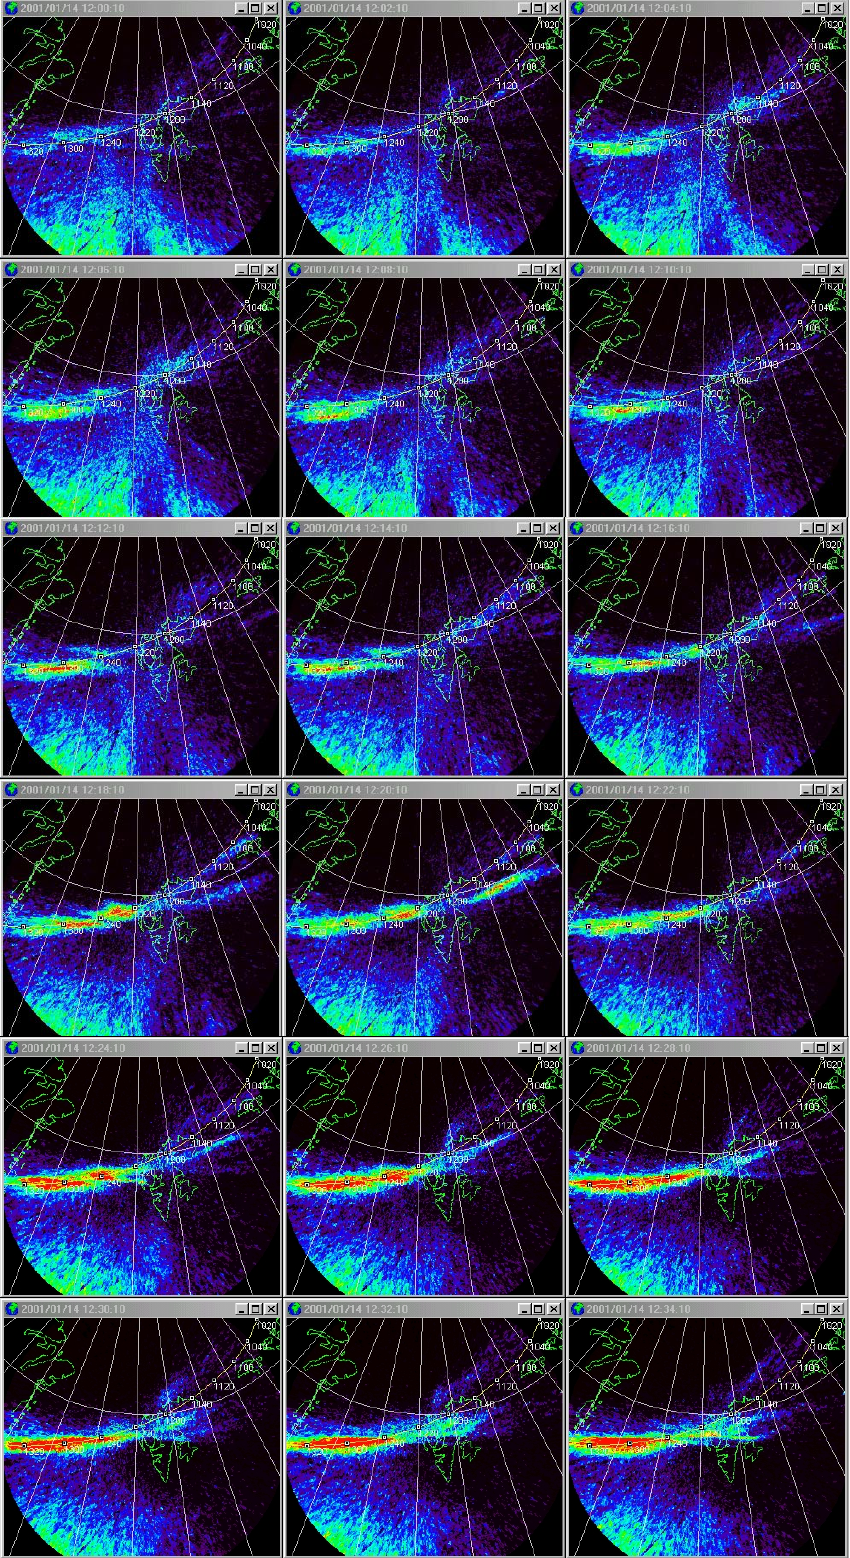
Fig. 13. One-minute integrations (shown every 2min) of 630nm emissions seen by the Norwegian all-sky camera at Ny ˚Alesund, Svalbard. Each frame shows the outline of Svalbard and, the east coast of Greenland and lines of constant geographic latitude and longitude, and the mapped footprint of the Cluster spacecraft. All emissions have been mapped assuming an emission altitude of 250km. The images are ordered from left to right in each row and rows are ordered from top to bottom. The first image (top left) is for 12:00 and the last (bottom right) is for